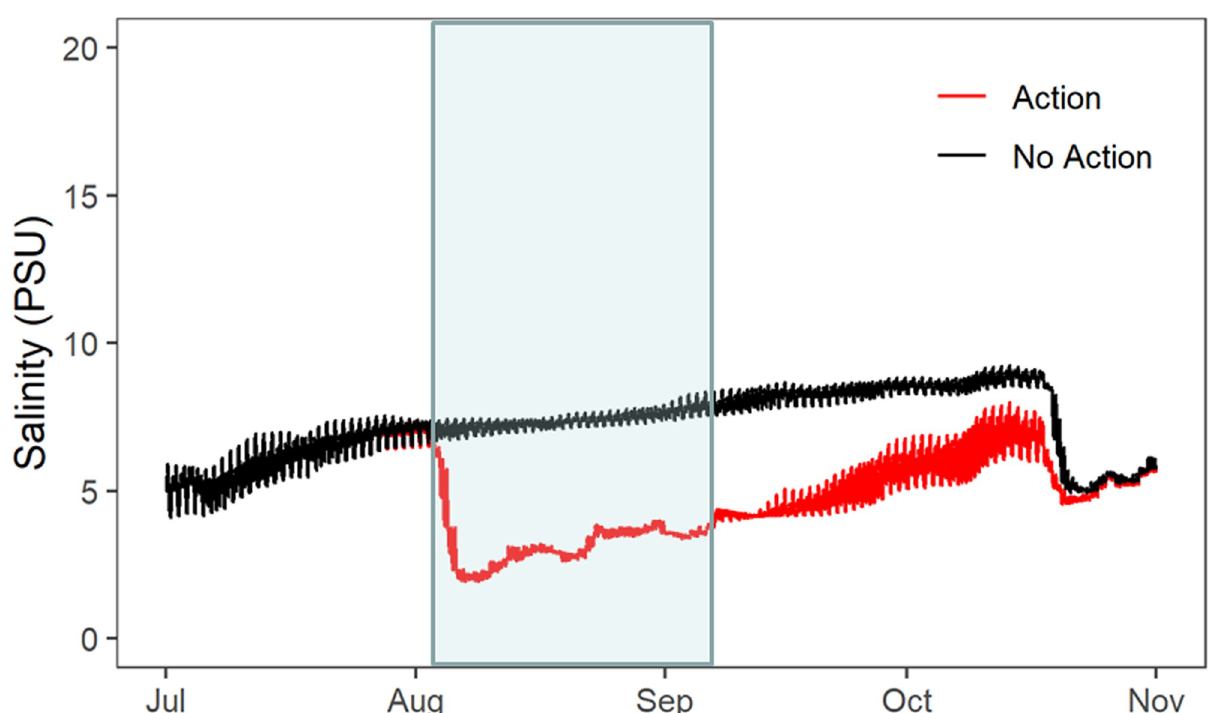
Fig 6. UnTRIM 3-D modeled salinity (psu) in the eastern Marsh (Belden’s Landing) for simulations with and without the Flow Action. The period of gate operations is highlighted in blue.